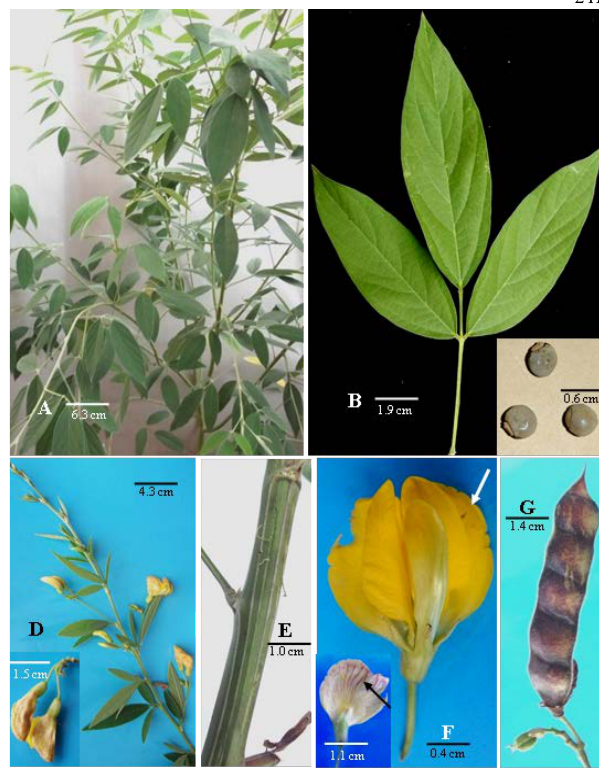
Fig. 6. Morphology of Cajanus cajan (L.) Millsp. A. Habit (shrub), B. Leaf, C. Seeds, D. Inflorescence (axillary cluster), E. Stem, F. Flower (black arrow points at reddish-brown veining and red arrow points at indented margin of the standard), G. Fruit (fresh)